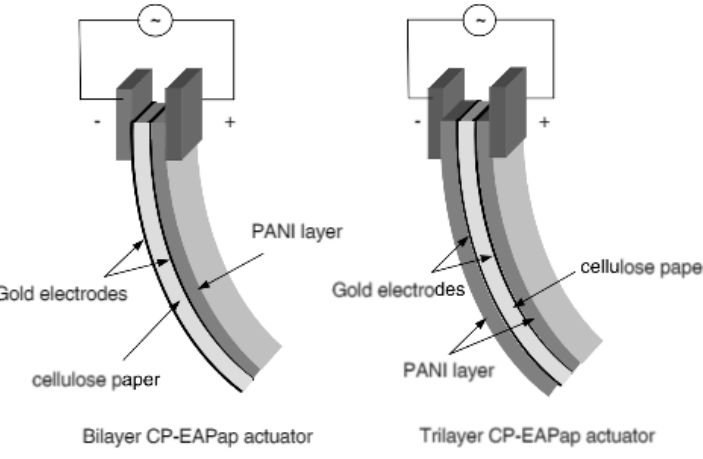
Figure 9. Schematic of bi‐layer and tri‐layer CP–EAPap actuators [51]. (PANI‐polyaniline)